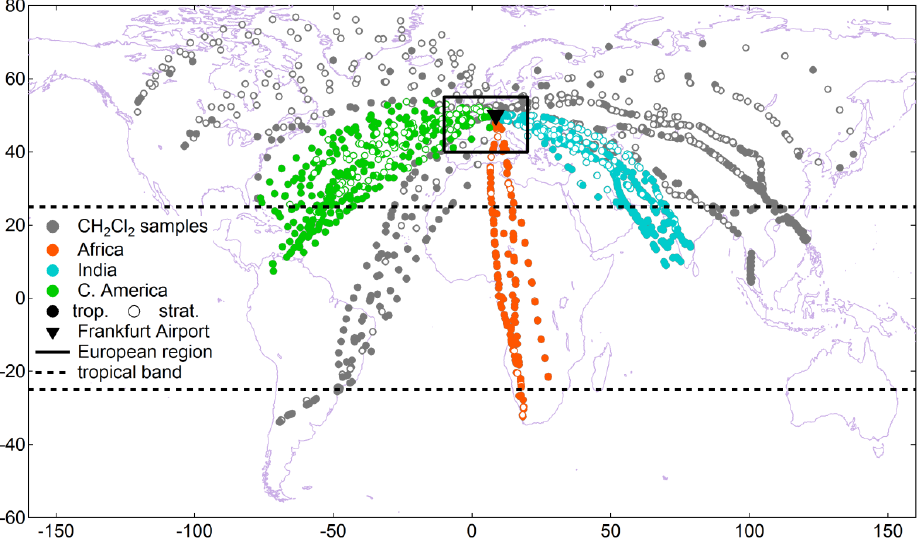
Figure 1. CARIBIC whole-air samples analysed for CH 2 Cl 2 between 1998–2002 and 2005–2012. The grey points show all the CH 2 Cl 2 samples collected by CARIBIC during these periods. The subset of data used in this study are also shown: (1) the samples within the European region described in Sect. 3 are marked by the black box, (2) flight routes to Africa, India and Central America are shown by coloured samples, see inset legend, and (3) samples within the tropical region are delineated by the dashed lines. More details of the regions used in this study can be found in Table 1.The identification of samples as tropospheric or stratospheric is described in Sect. 2.